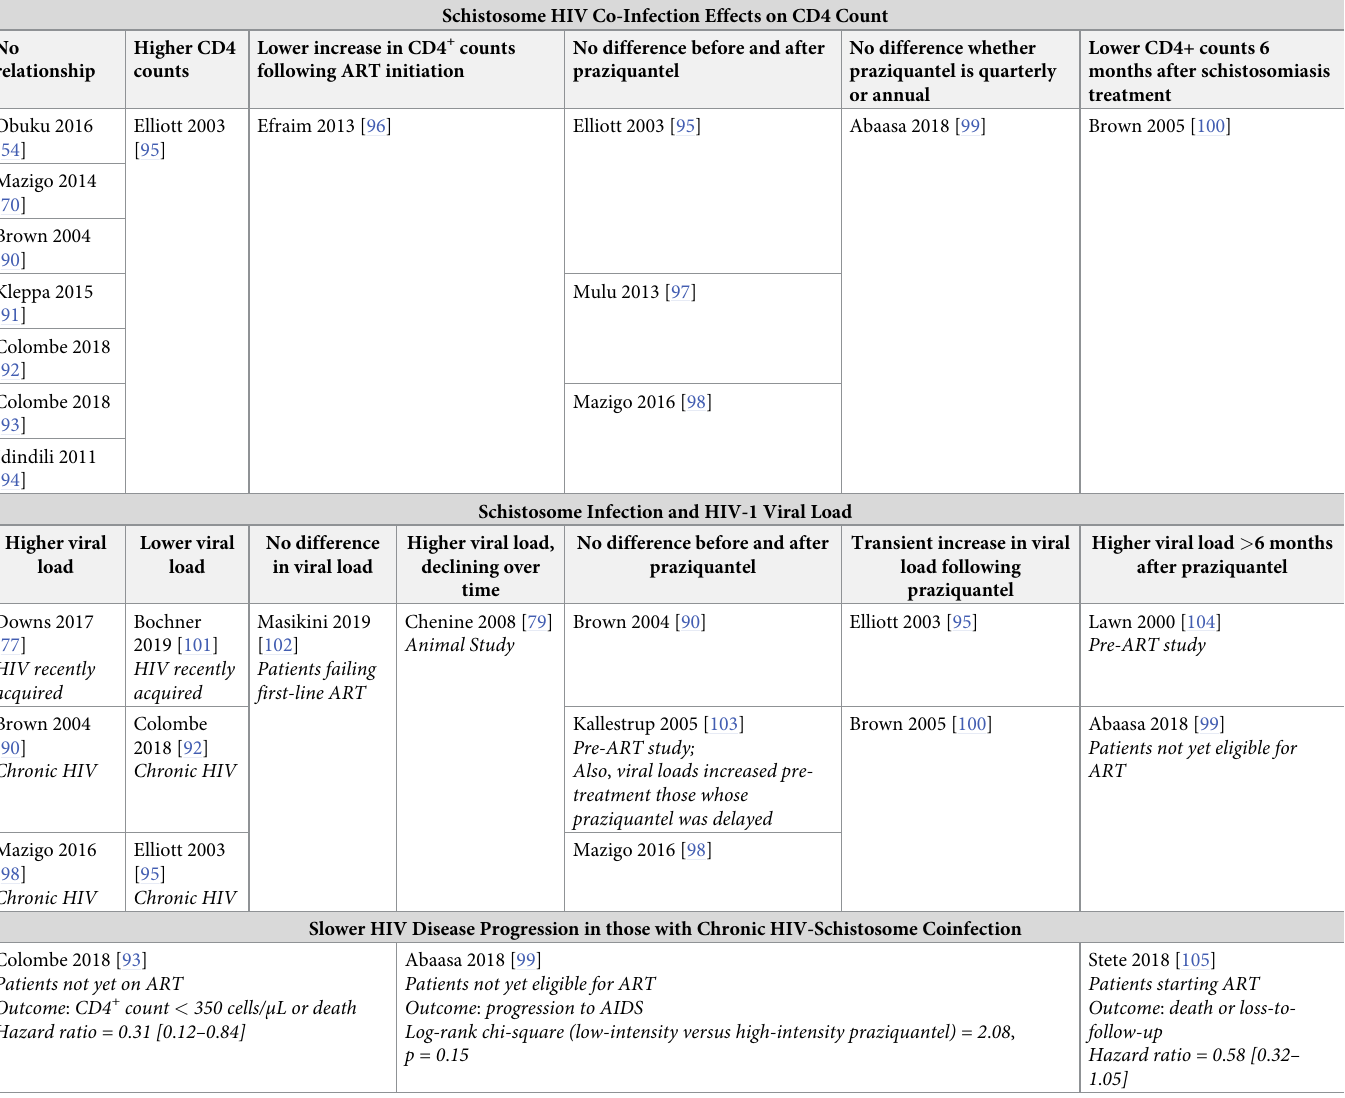
Table 5. Effects of Schistosome-HIV Coinfection on CD4 + T Cell Counts, HIV-1 RNA Viral Load, and HIV Disease Progression. Schistosome HIV Co-Infection Effects on CD4